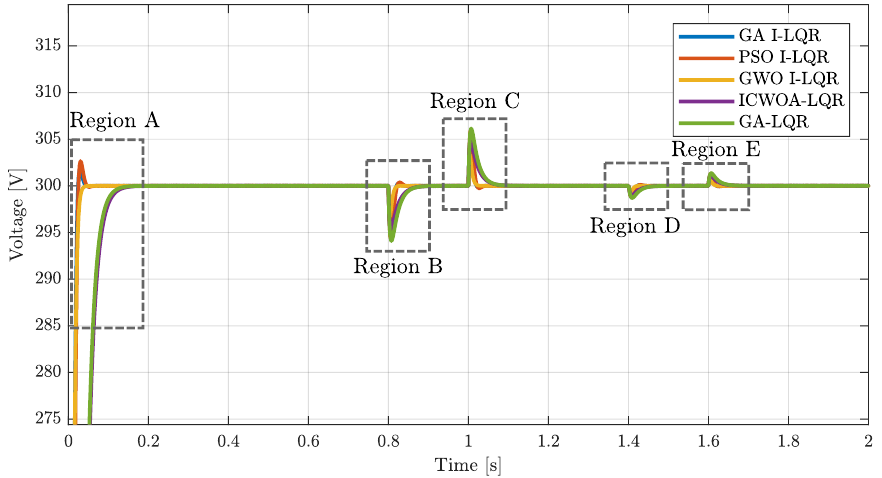
Figure 13. Step response of all the IBC controllers when subject to the conditions from Figures 10 and 11. The boxed regions represent the regions of interest.